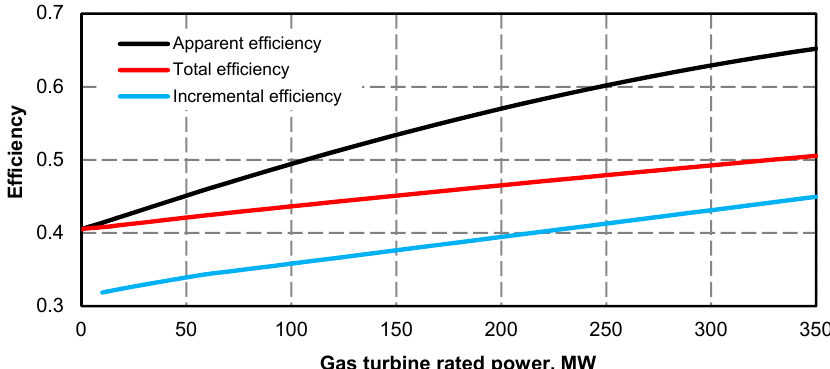
Figure 33. The energy efficiency for the power unit with superstructure added as a function of gas turbine rated power for a maximum fixed stream of 319.4 kg/s fresh steam fed to the steam turbine.